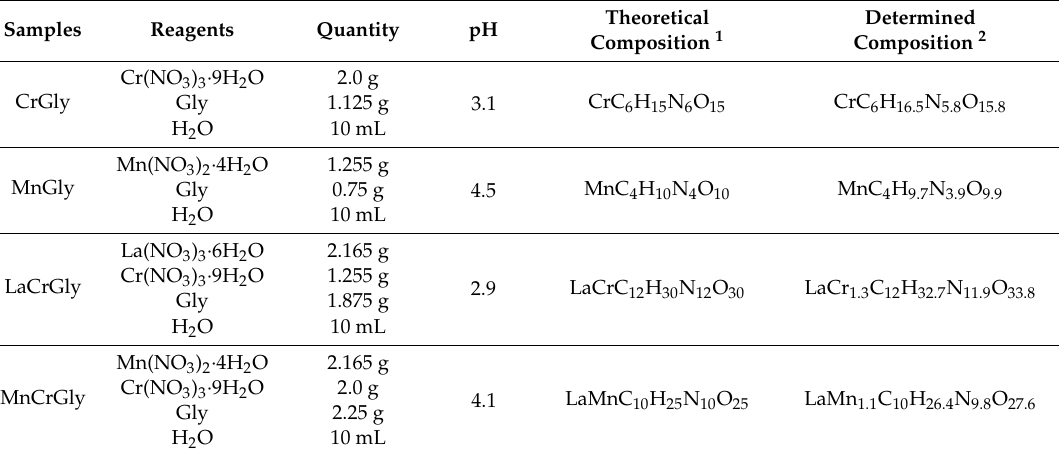
Table 1. Data on the preparation of glycine–nitrate